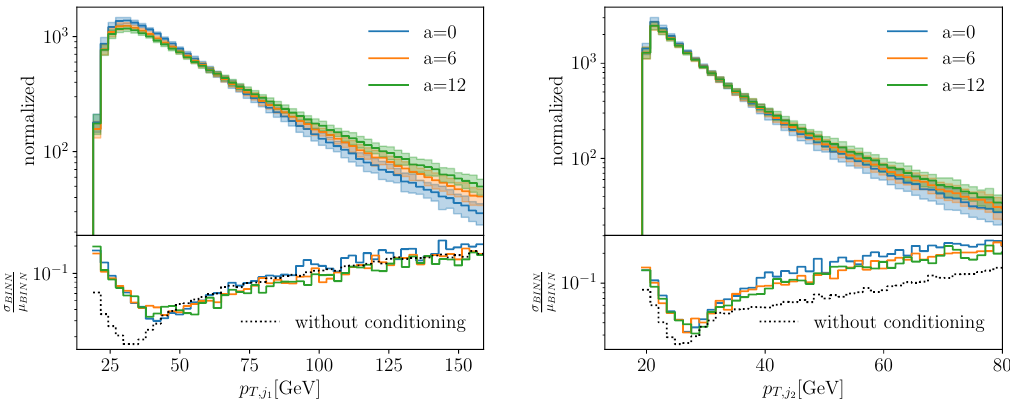
Figure 13: BINN densities for Z + jets and conditional training with an enhanced-tail augmentation in p , as defined in T , 1